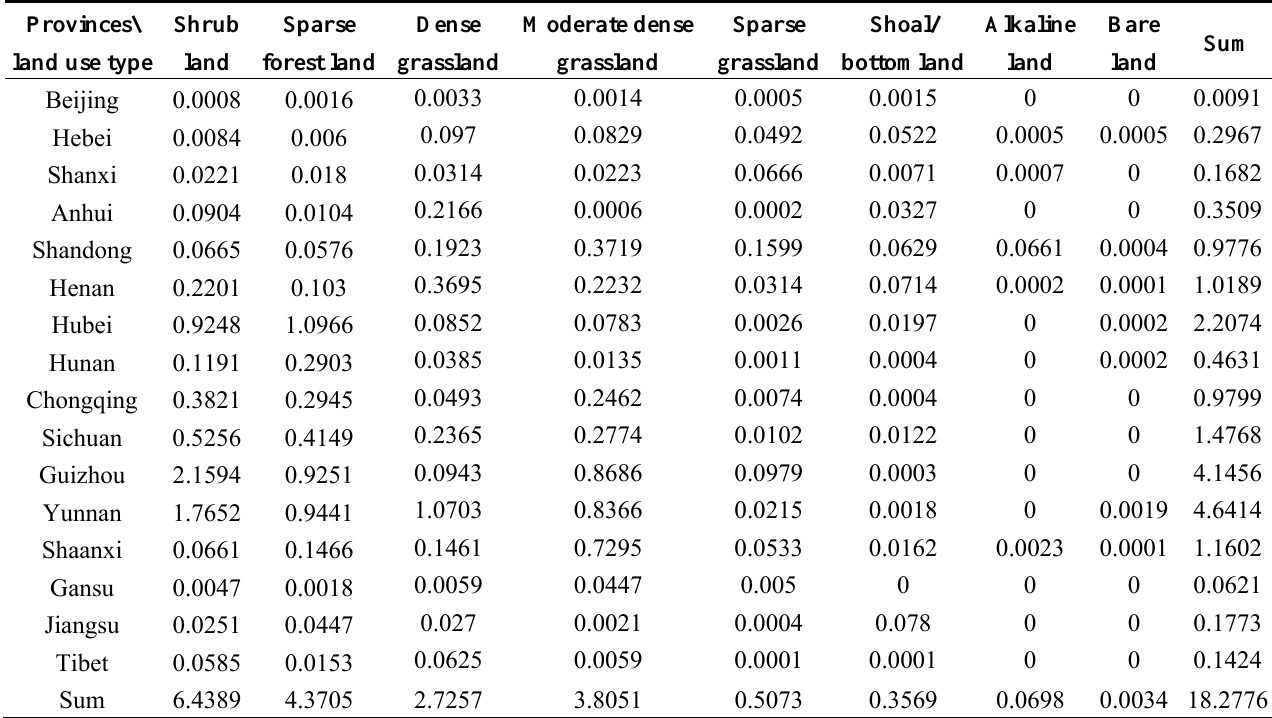
Table 3. Evaluation results of marginal land of each province suitable for planting Pistacia chinensis (million ha).